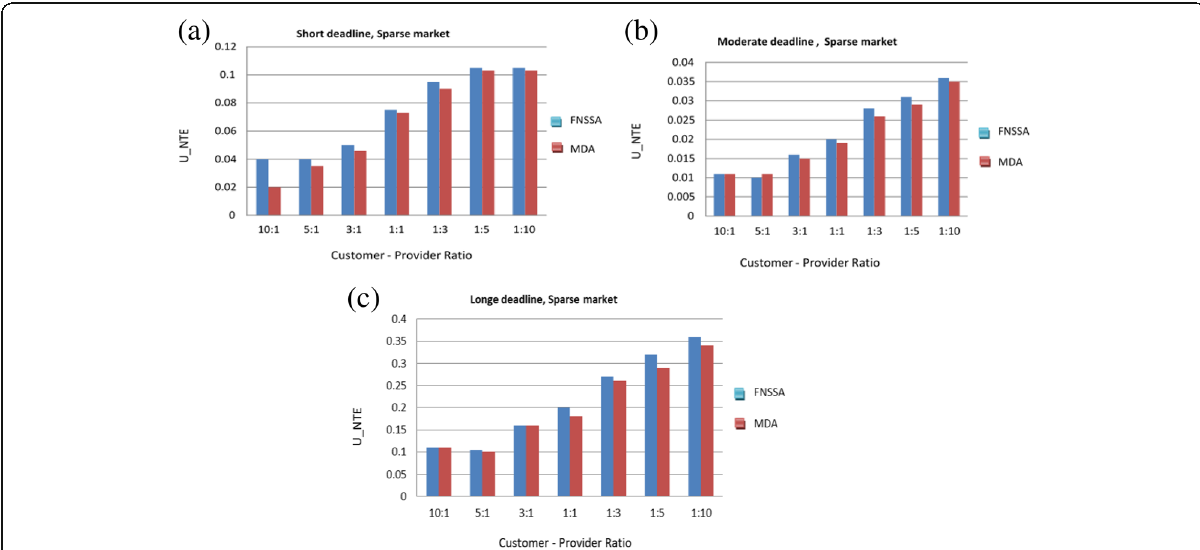
Fig. 8 The U_NTE of the CRBAs under a short deadline and sparse market, b moderate deadline and sparse market, and c long deadline and sparse market. In all figures different market types are